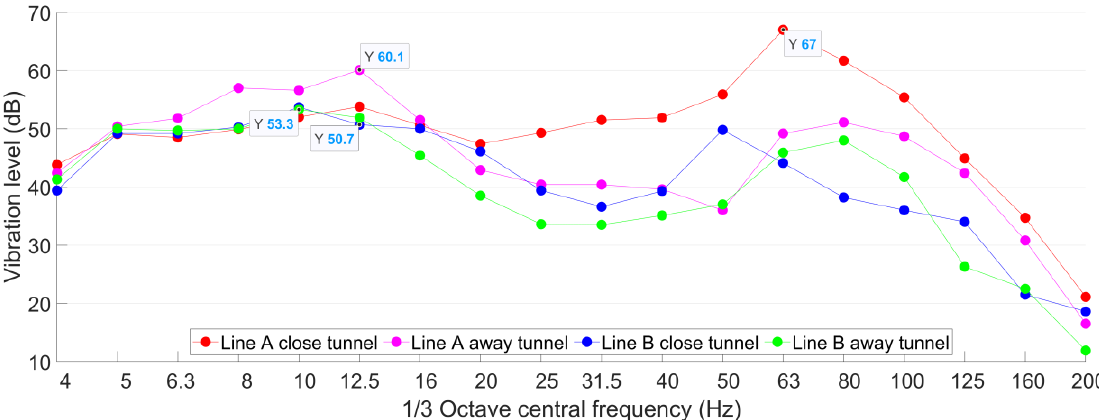
Figure 8. Ground 1/3 octave frequency division vibration acceleration level of Line A and Line B in P1.